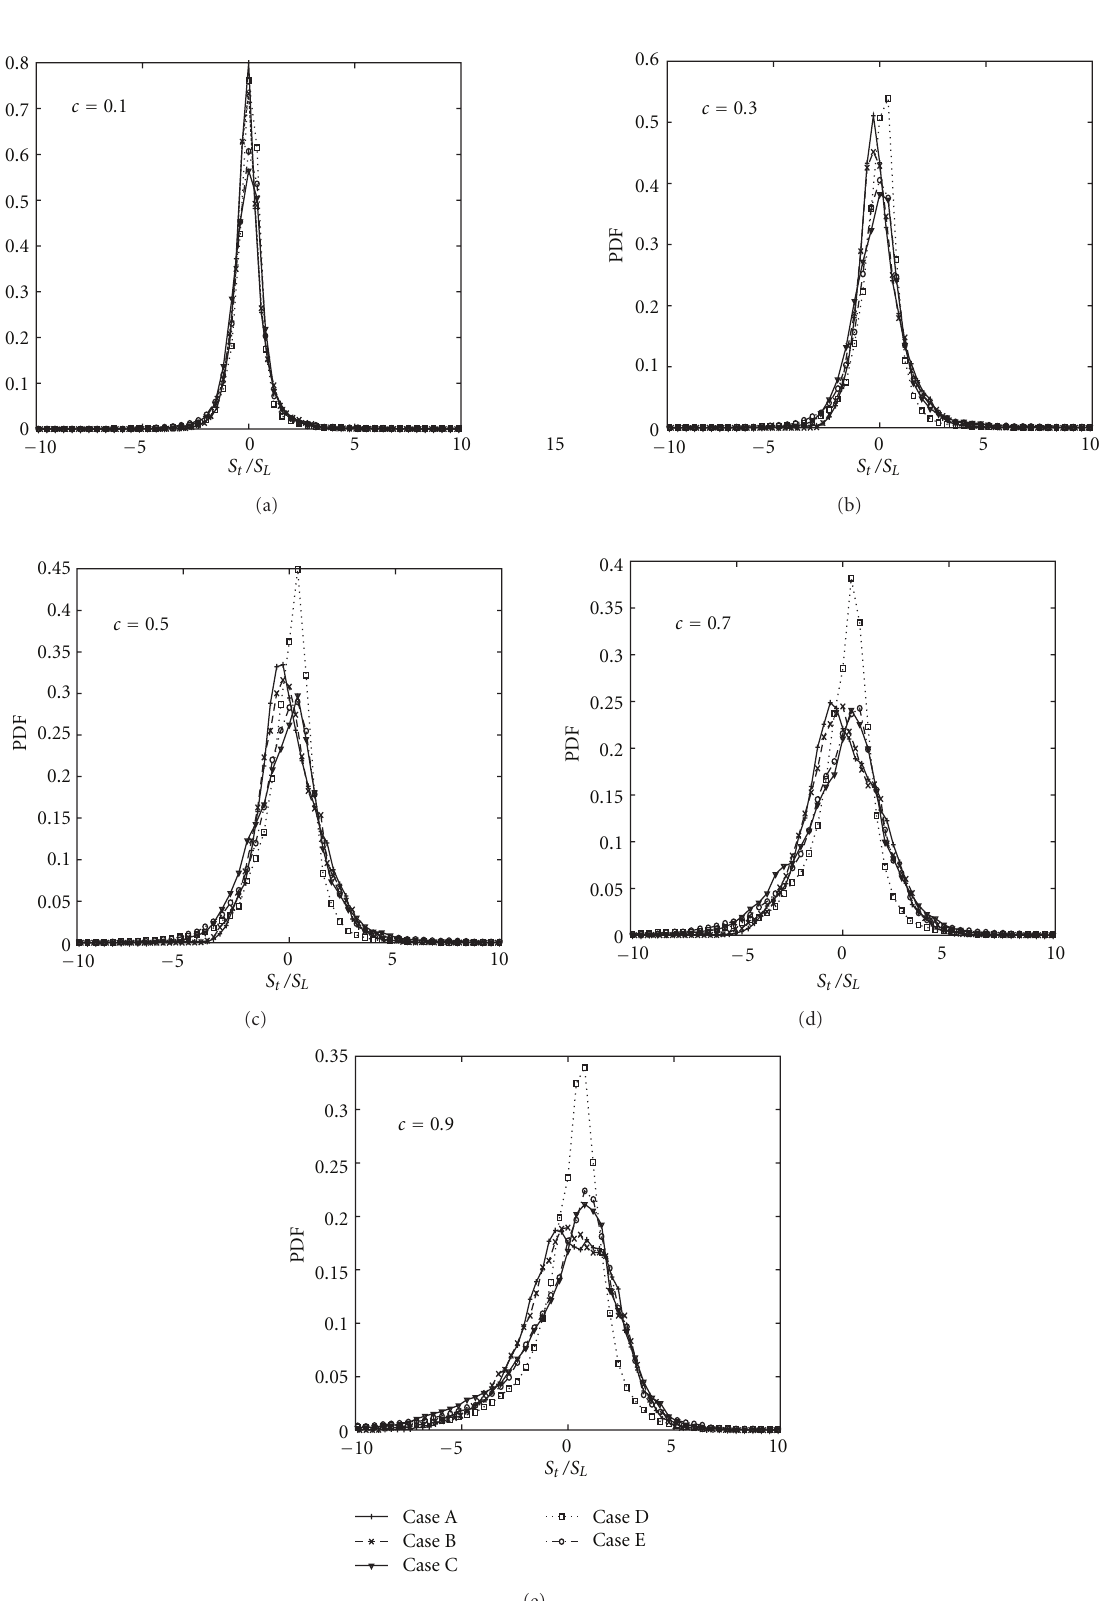
Figure 4: Pdfs of normalised tangential di ff usion component of displacement speed S t /S L on the c = (a) 0.1, (b) 0.3, (c) 0.5, (d) 0.7, and (e) 0.9